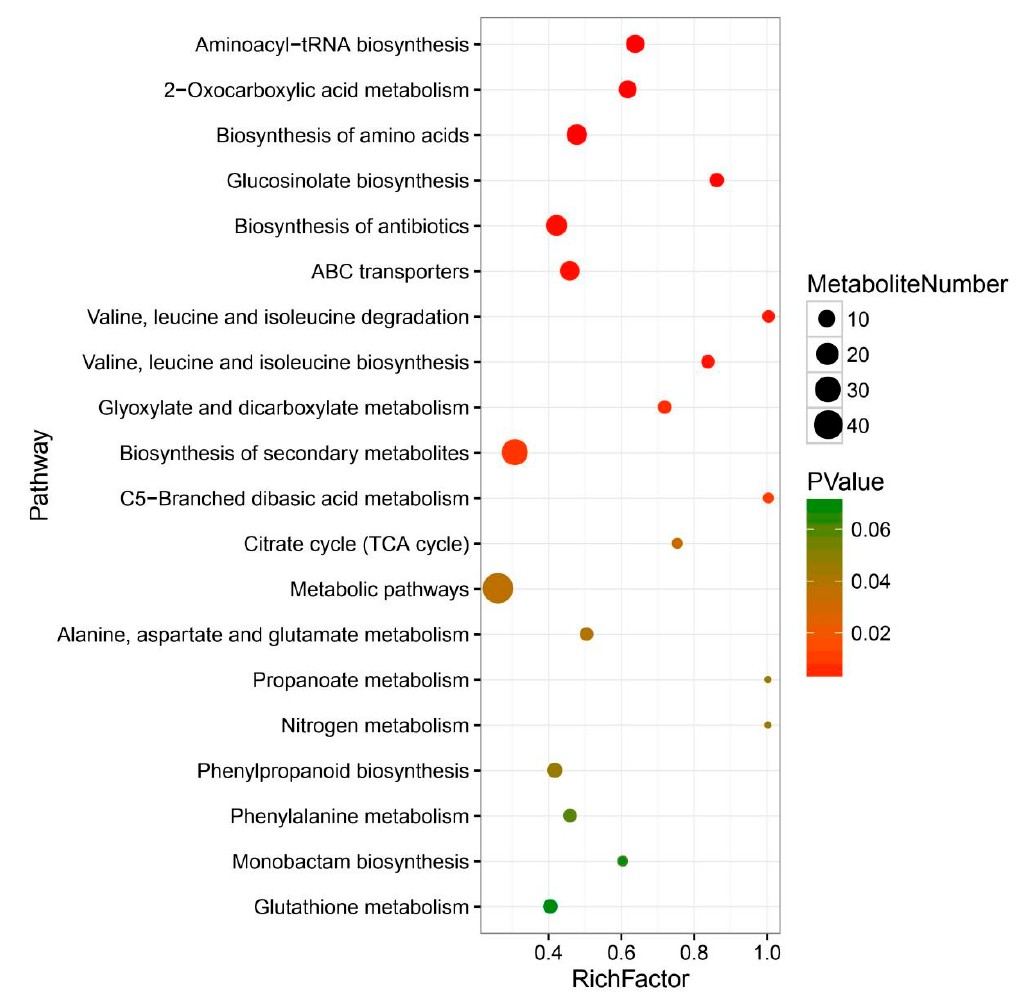
Figure 4. Kyoto Encyclopedia of Genes and Genomes (KEGG) pathway enrichments of differential metabolites in TOP20.